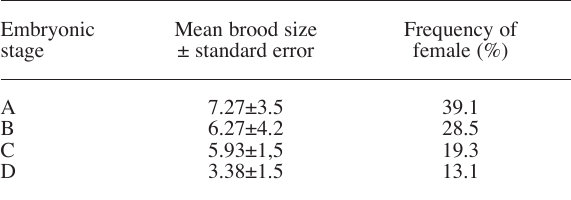
T ABLE 2. – Brood size of the embryonic stages and the percentage of females carrying embryos at these stages in the total number of brooding C. insidiosum